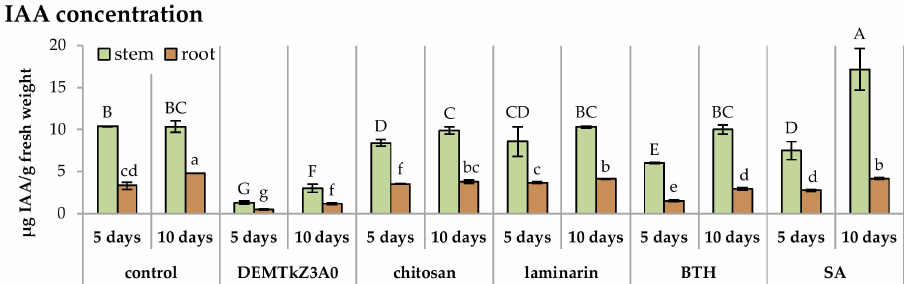
Figure 15. The indoleacetic acid concentration (IAA) in stem and root of wheat seedlings after 5 and 10 days inoculation with Trichoderma DEMTkZ3A0 strain and potential inducers (commercial elicitors) of plant resistance: Chitosan, laminarin, BTH, and SA.